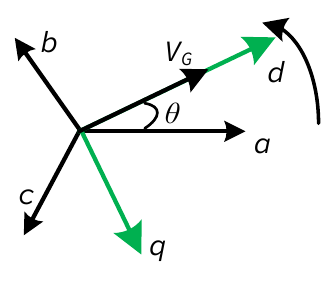
Figure 3. Coordinate transformation.